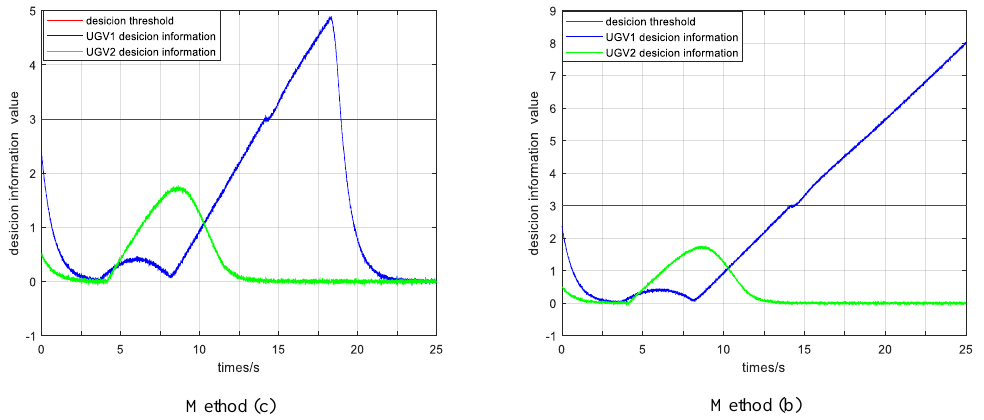
Figure 8. The figure shows the decision variables of method (c) with the wrong intervention first, then the correct intervention and method (b) with wrong intervention.